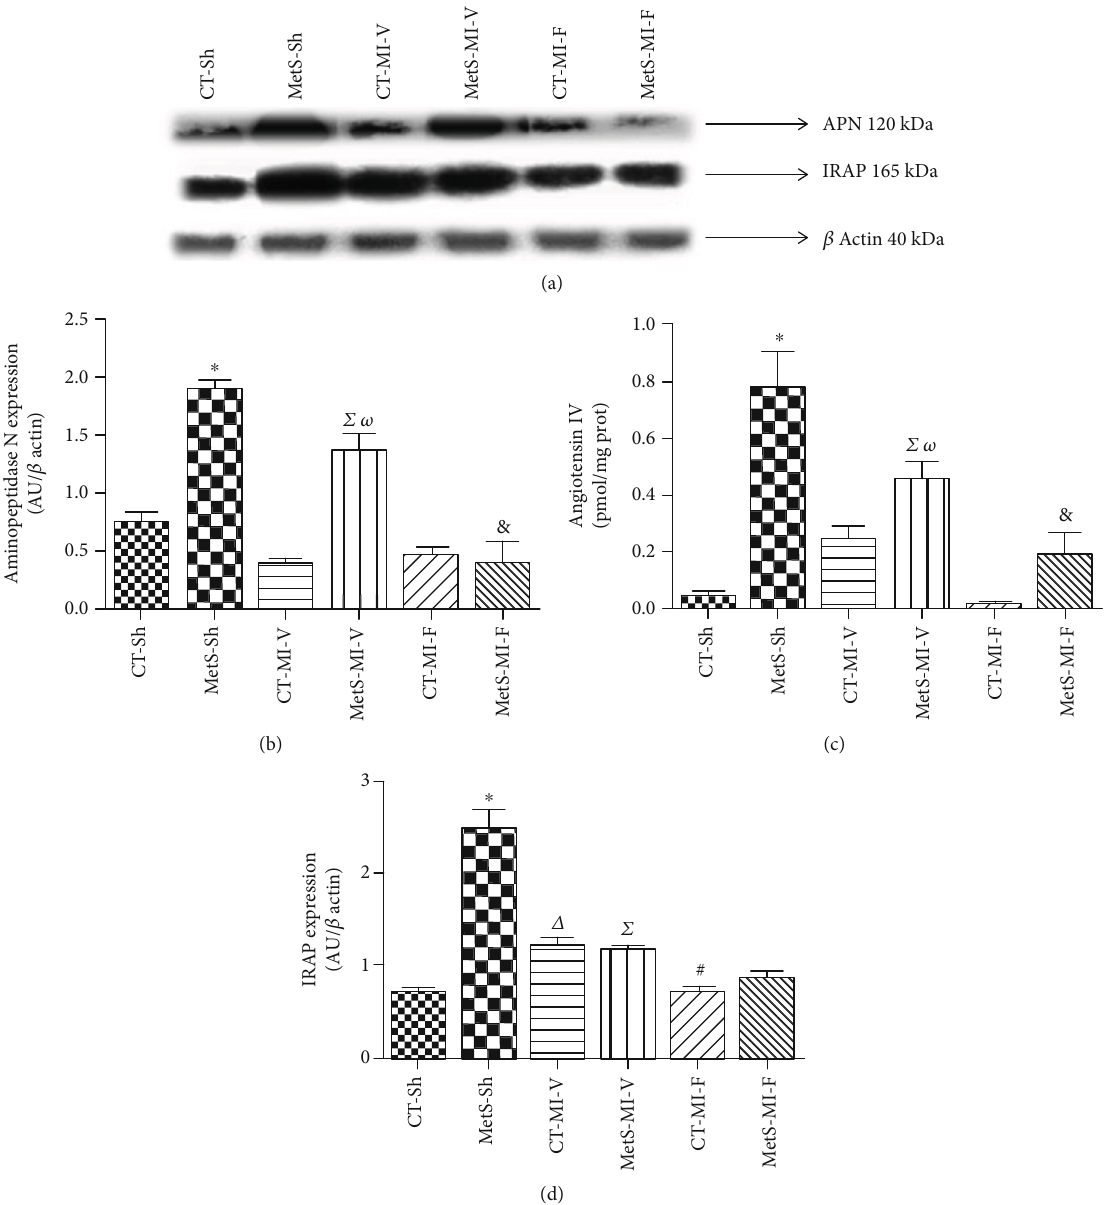
Figure 5: E ff ect of feno fi brate administration on myocardial aminopeptidase N (APN) expression in myocardial tissue from the control (CT) and metabolic syndrome (MetS) animals. (a) Representative image. (b) Angiotensin IV concentration. (c) Insulin-regulated aminopeptidase (IRAP) protein expression. The values show the mean ± SEM ( n = 5 per group). ∗ p < 0 : 05 vs. CT-Sh; Δ p < 0 : 05 vs. CT-Sh; Σ p < 0 : 05 vs. MetS- Sh; # p < 0 : 05 vs. CT-MI-V; ω p < 0 : 05 vs. CT-MI-V; & p < 0 : 05 vs. MetS-MI-V. Analysis of